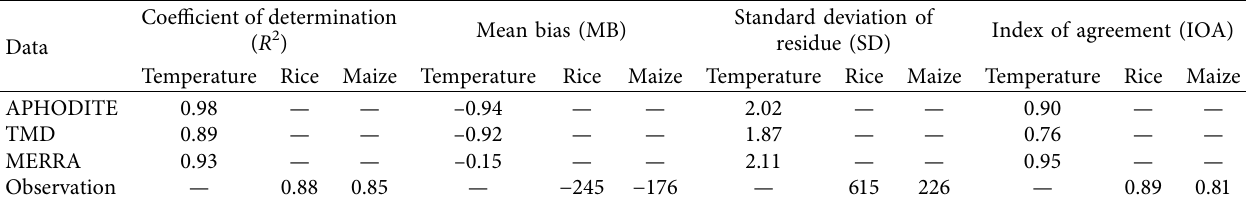
Table 2: The statistical analysis comparing the modeled and observed temperatures (adapted from [6, 27, 28]). Coefficient of Data